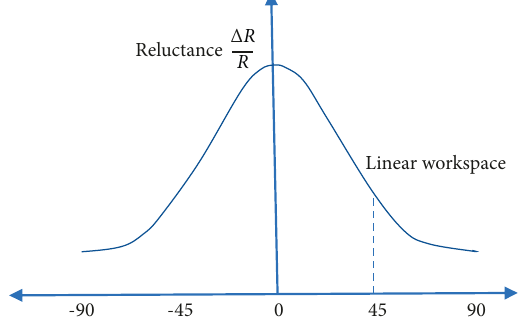
Figure 1: Relationship between magnetoresistance and angle be- tween magnetic field and